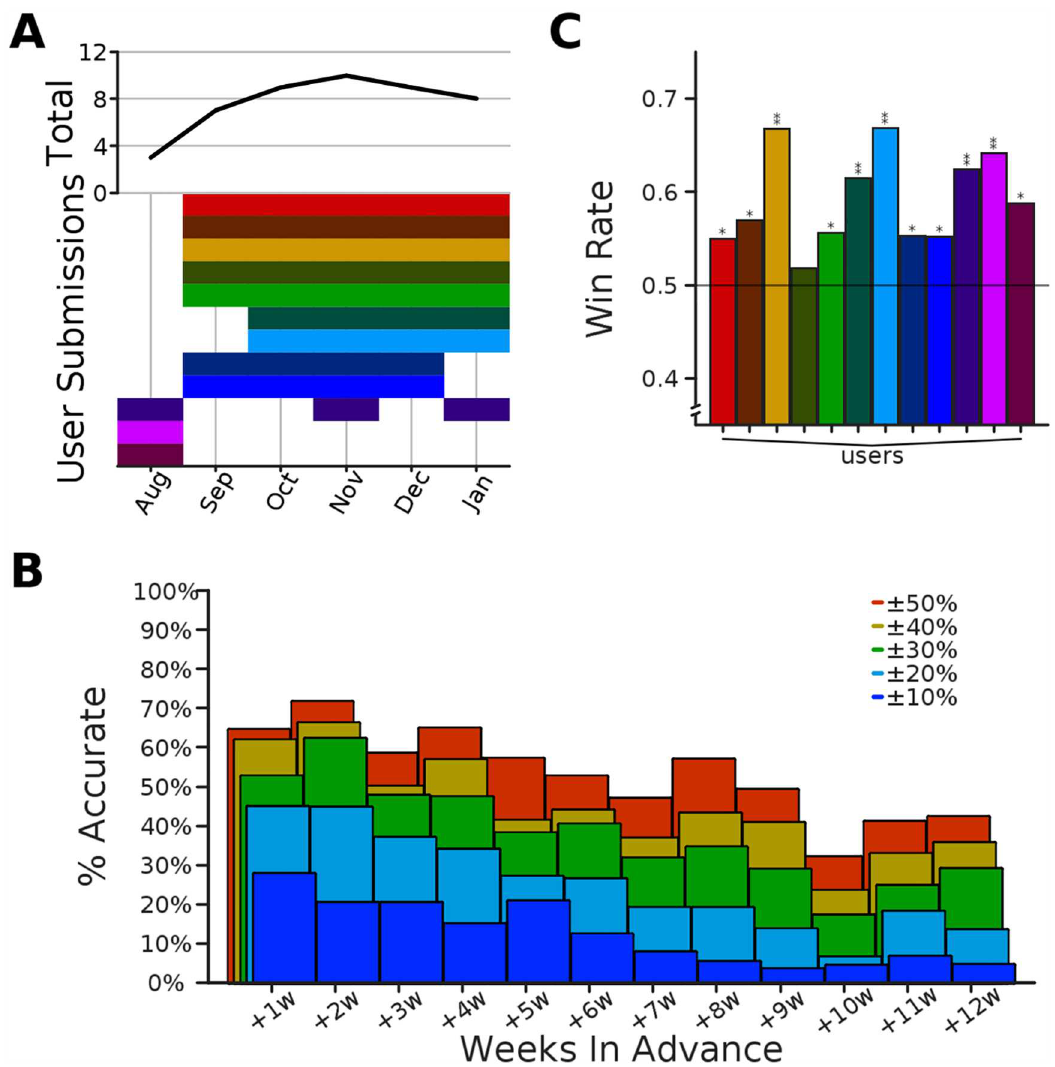
Fig 8. Overviewof chikungunya predictions. (A) Similar to Fig 2, participation is shown per month (top) and per expert (bottom). (B) As in Fig 3, percent of predictions within some range of the target value as a function of the number of weeks in advancethat the predictionwas made (45 (cid:20) n (cid:20) 84). (C) As in Fig 5, the fraction of instanceswhere Epicast had lower absoluteerror than each individual participant, across all countriesand weeks (336 (cid:20) n (cid:20) 795; Sign test; * : p < 10 − 2 ; ** : p < 10 − 5